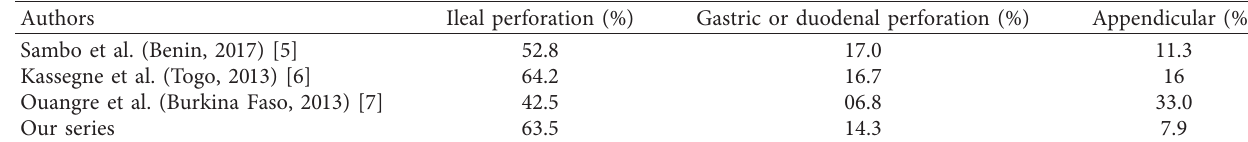
Table 5: Acute generalized peritonitis etiologies according to sub-Saharan